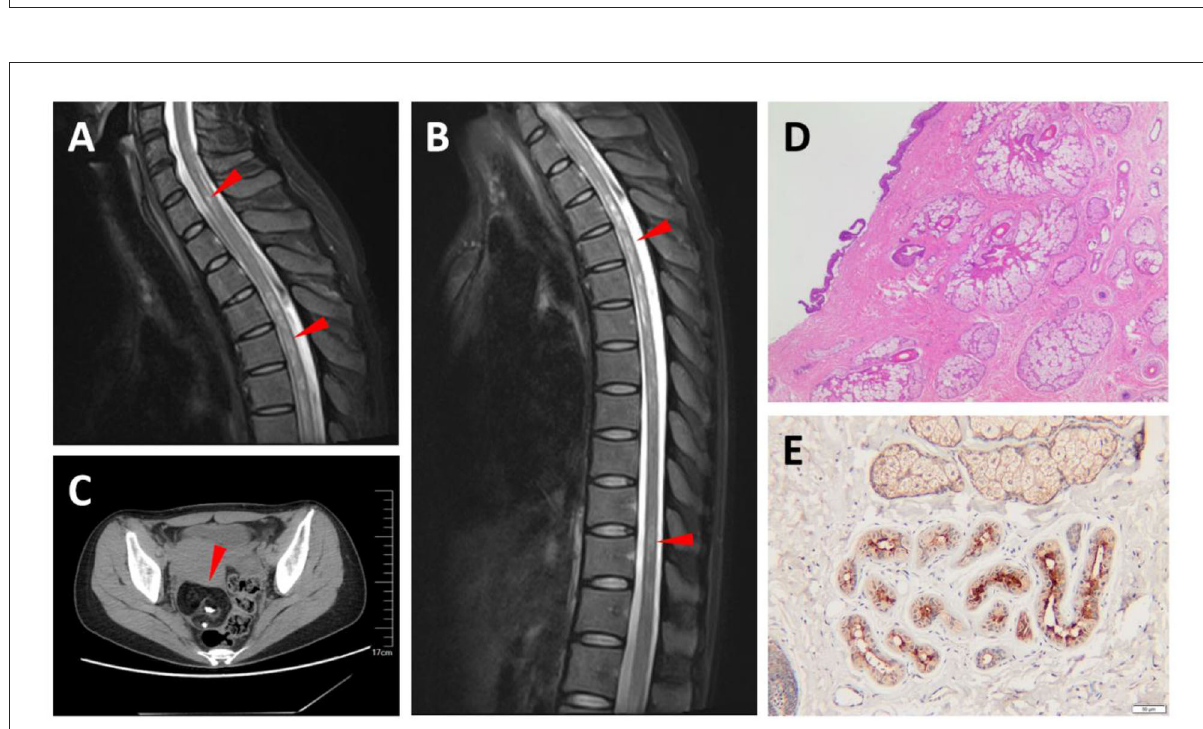
FIGURE2 Magnetic resonance imaging (MRI) and pathological findings of Case 2. T2-weighted MRIs show abnormal signals in the cervical and thoracic spinal cord (arrowhead) (A,B) . An abdominal computed tomography (CT) shows a tumor in the right ovary, in which calcification and fat were observed, and suggests an ovarian teratoma (arrowhead) (C) . Hematoxylin and eosin (H&E) staining of teratoma section (D) . Teratoma section stained with aquaporin-4 (AQP-4)-specific monoclonal antibody shows intense immunoreactivity (E)